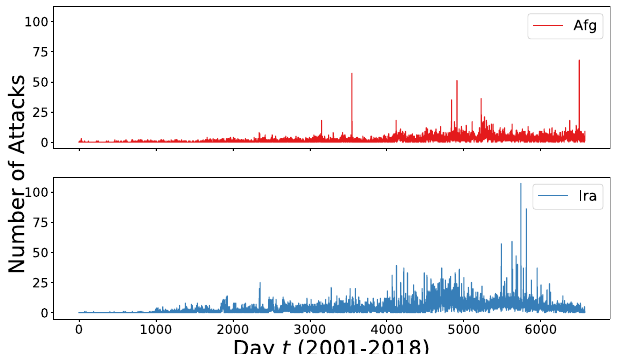
Figure 1. Time-series of terrorist attacks at the day level in Afghanistan (top) and Iraq (bottom). The figure has been created using Matplotlib version 3.1.3. Url: https:// matpl otlib. org/3. 1.3/ conte nts.